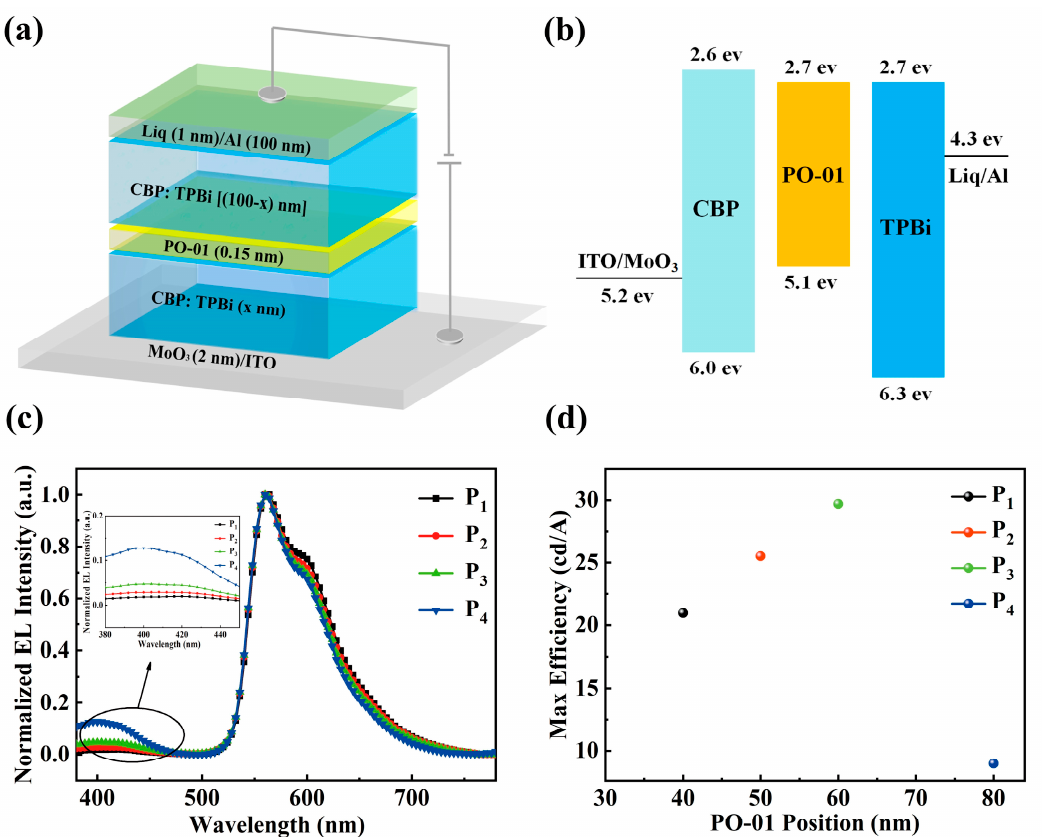
Figure 3. ( a ) The structure of devices P 1 –P 4 ; ( b ) the specific energy level diagram of the used materials; ( c ) the normalized EL spectra of devices P 1 –P 4 at 7 V (inset: partial magnified EL spectra); ( d ) the maximum CE-PO-01 position characteristics of devices P 1 –P 4 .